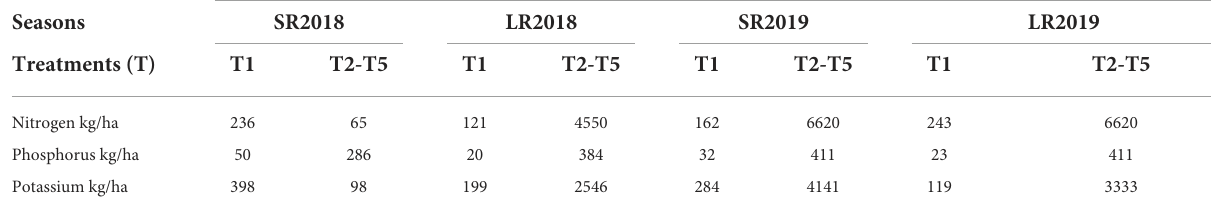
TABLE 2 Nutrient content of plant residues recycled into the soil in the four crop-growing seasons of 2018 and 2019. Nutrient Total maximum nutrient content in plant residues obtained per season